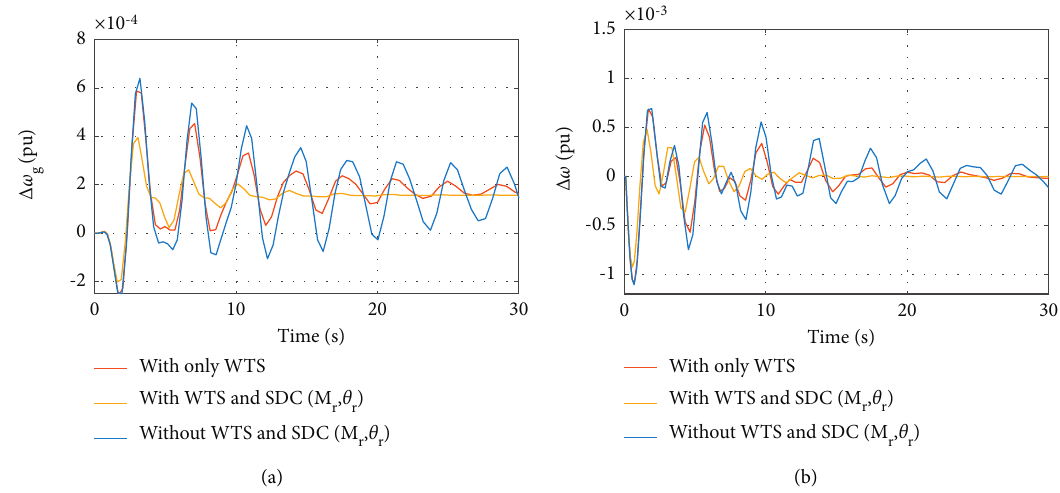
Figure 9: (a) The rotor speed deviation in WPP ( V displacement of rotor in WPP ( V w ≈ 8m/s). (d) The load angle deviation in CPP ( V w ≈ 8m/s). (e) The common terminal voltage ( V w ≈ 8